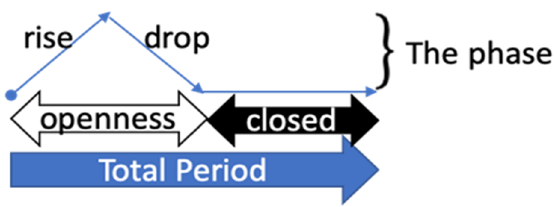
Figure 4. Phased LSTM time gate: phase visualization [14].